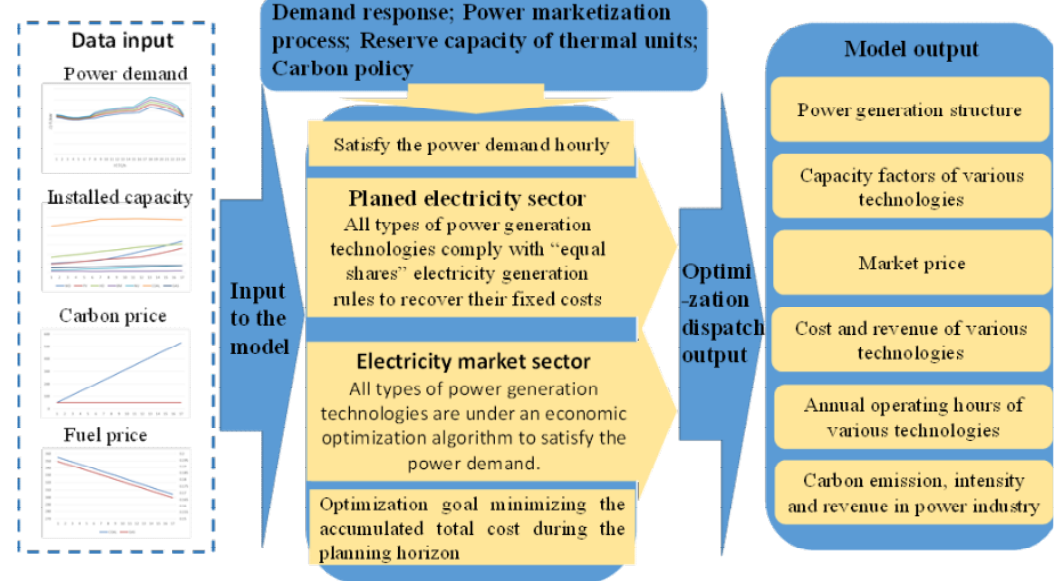
Figure 1. An illustrative structure of the model.